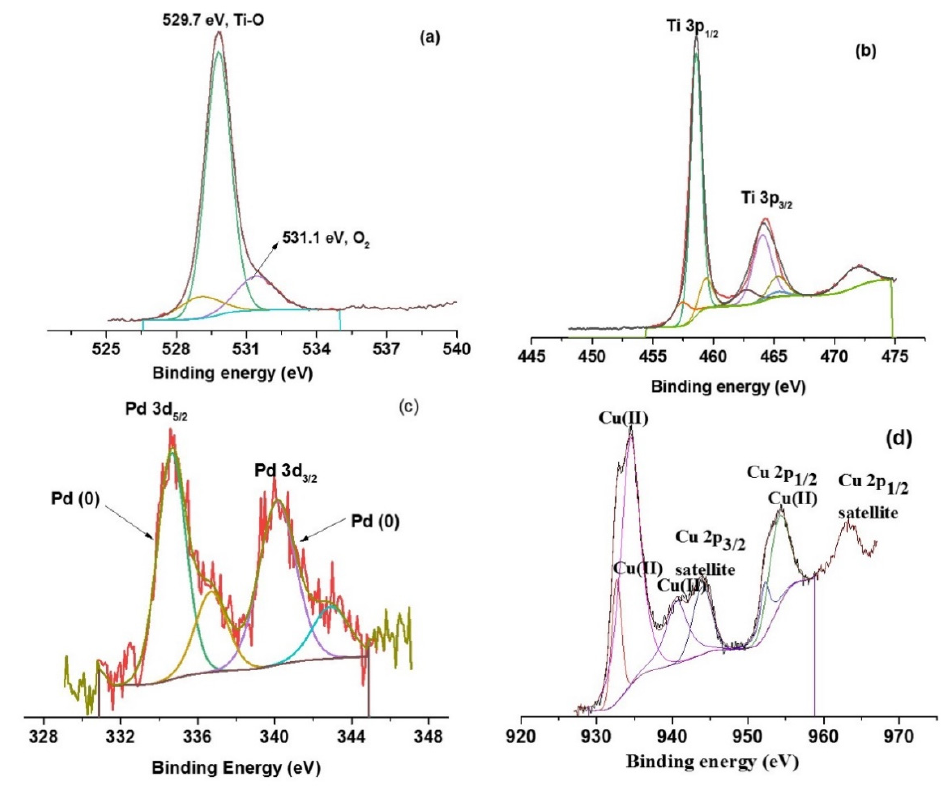
Figure 4. Core level XPS spectra of 0.5Pd-0.5Cu/TiO 2 ( a ) O 1s, ( b ) Ti3p, ( c ) Pd3d, and ( d ) Cu